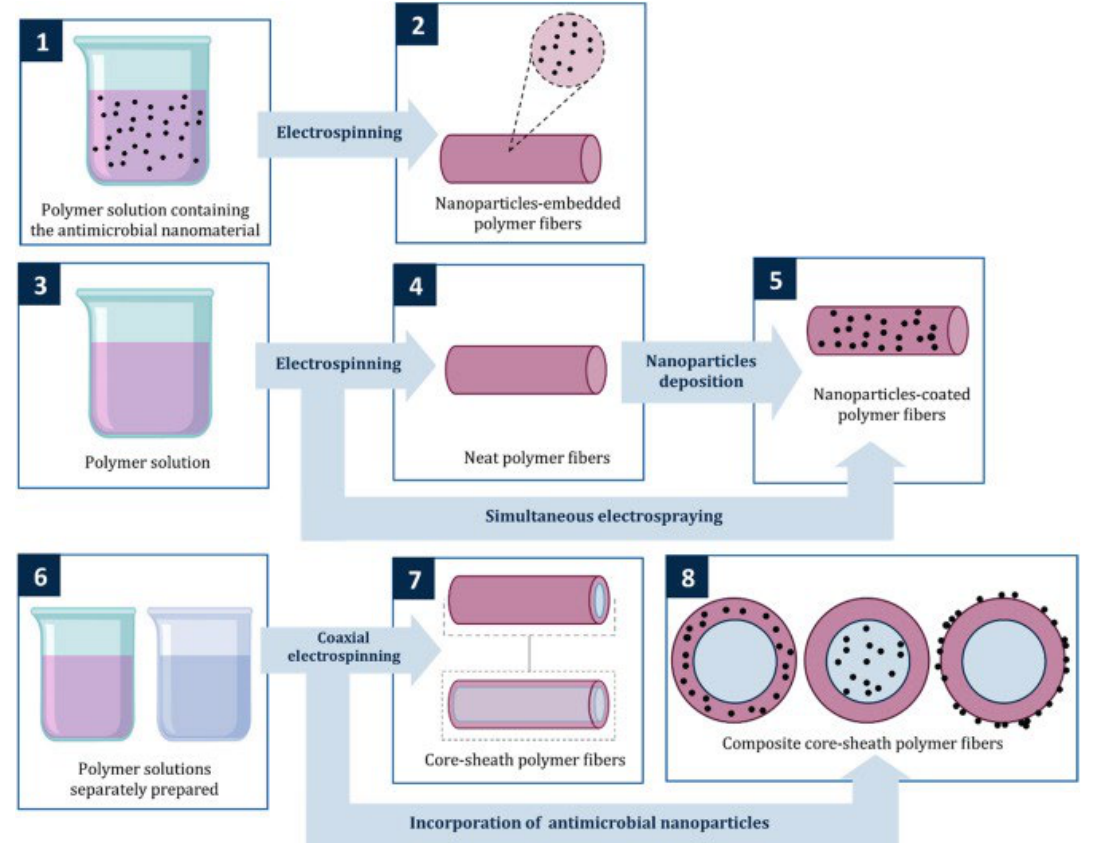
Figure 3. Scheme of methodologies for constructing composite fiber materials manufactured by electrospinning and related processes, as well as the corresponding outer and inner morphologies: (1–2) simple electrospinning, (3–5) electrospinning/electrospraying, and (6–8) coaxial electrospinning [84]. Reprinted from Materials Science and Engineering: C, Vol 101, Heriberto Rodr í guez-Tob í